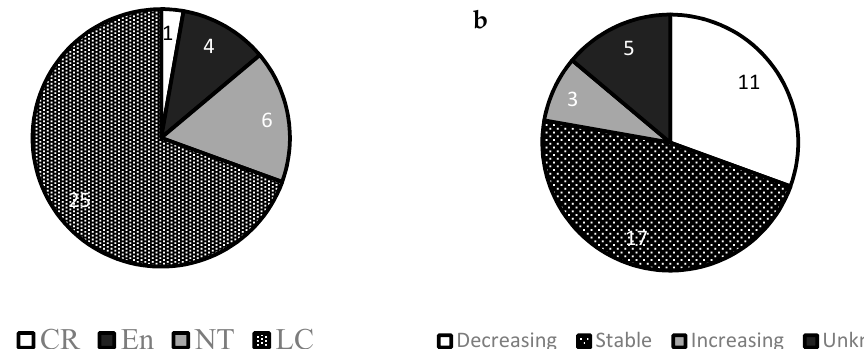
Figure 1. ( a ) Numbers of wild canid species listed as critically endangered (CR), endangered (En), near threatened (NT) or least concern (LC) status according to the IUCN red list of endangered species; ( b ) Numbers of canid species with decreasing, stable, increasing or unknown population trends.